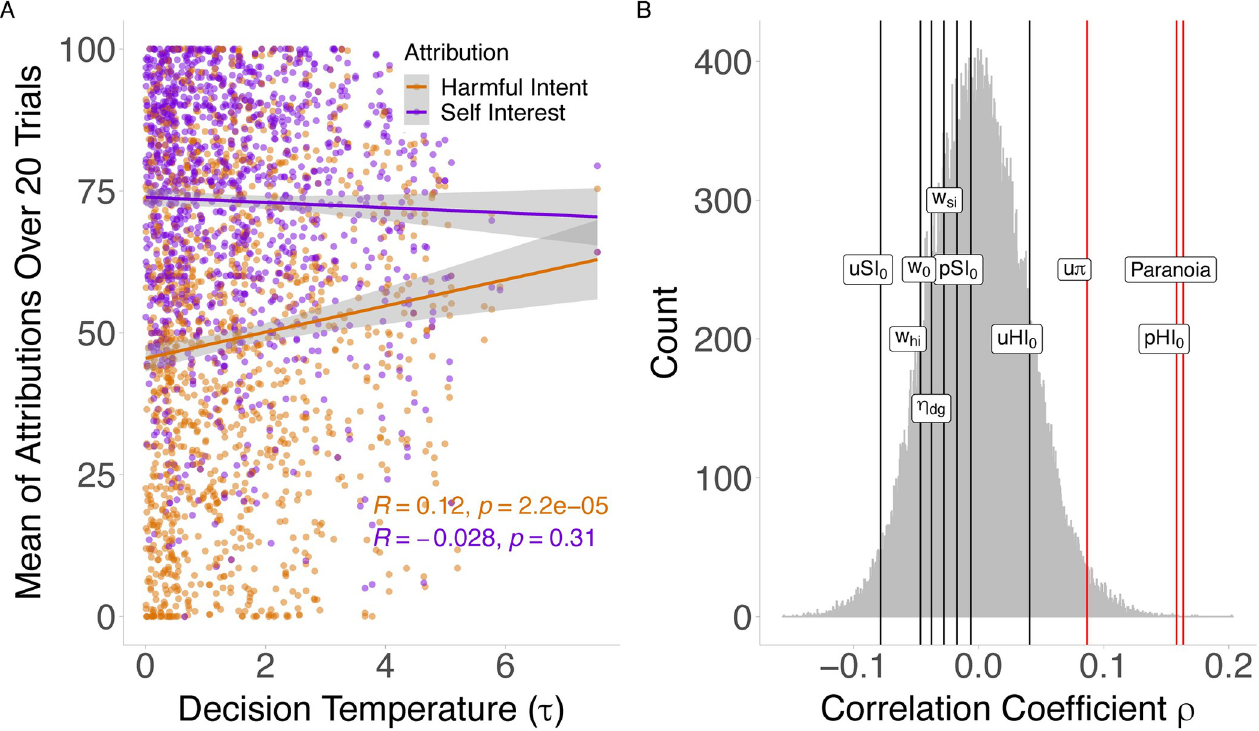
Fig 3. The relationship between decision temperature, attributions, and social task parameters. (A) Spearman correlations between decision temperature and mean attributions observed summed across 20 trials for each participant. (B) Permutation analysis of the relationship between decision temperature, and computational model-based parameters from the winning model and pre-existing paranoia. The grey distribution represents the null distribution following random sampling of the population for each Spearman pairwise correlation. The true Spearman correlations of each social parameters against tau are depicted for each parameter. Only the strength of prior beliefs over harmful intent (pHI 0 ; ρ = 0.16, p ~ 0), uncertainty over partner policies (u π ; ρ = 0.09, p permuted permuted = 0.015), and paranoia ( ρ = 0.16, p ~ 0) were associated with decision temperature. Red lines denote that the observed correlation with tau is very permuted unlikely due to chance (p < 0.05). Black lines denote the observed correlation is more likely due to chance (p > 0.05).